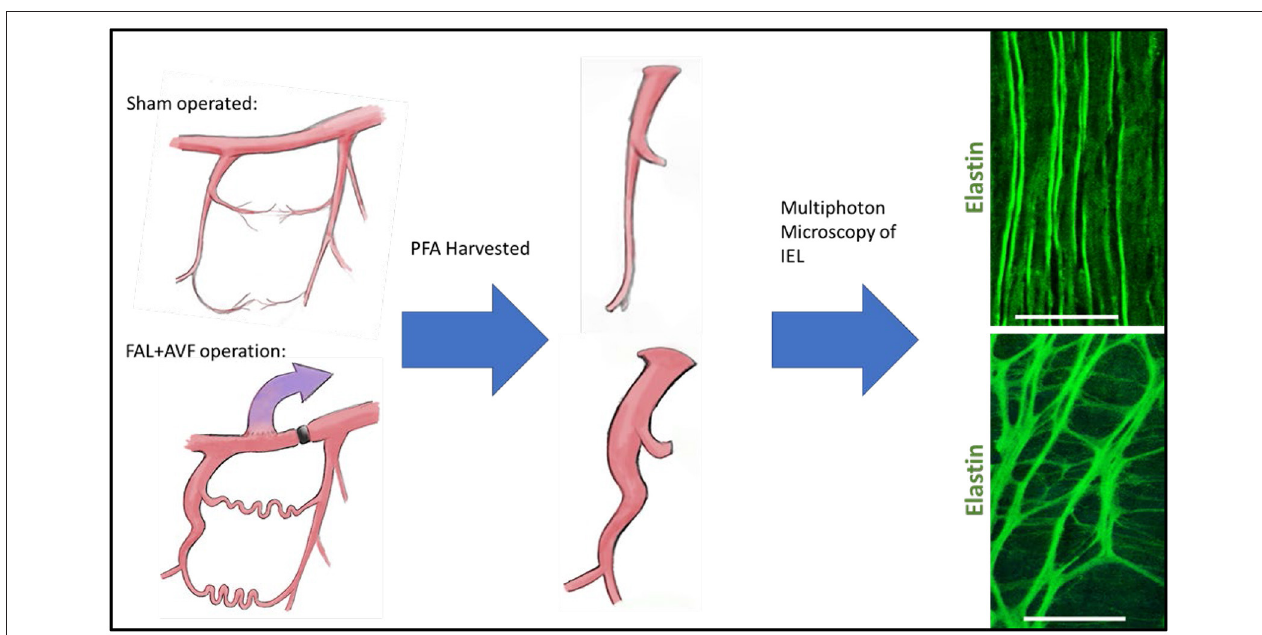
FIGURE 2 | Internal elastic lamina (IEL) remodeling in a rodent model of arteriogenesis. Rat hindlimbs were rendered ischemic by placement of femoral artery ligation with distal arteriovenous fistula or treated as controls with sham operation (incision and exposure without further arterial manipulation) as we have previously described ( 13). Profunda femoral arteries were harvested at 12 weeks and imaged with multiphoton microscopy. Note the wrinkled topology of the IEL with small regular fenestrations in the control vessel, which is lost in the remodeled vessel as the fenestrations are greatly enlarged. Images acquired with Olympus FV1000MPE utilizing 830nm laser. Bar = 50 um. Multiphoton microscopy methods described previously